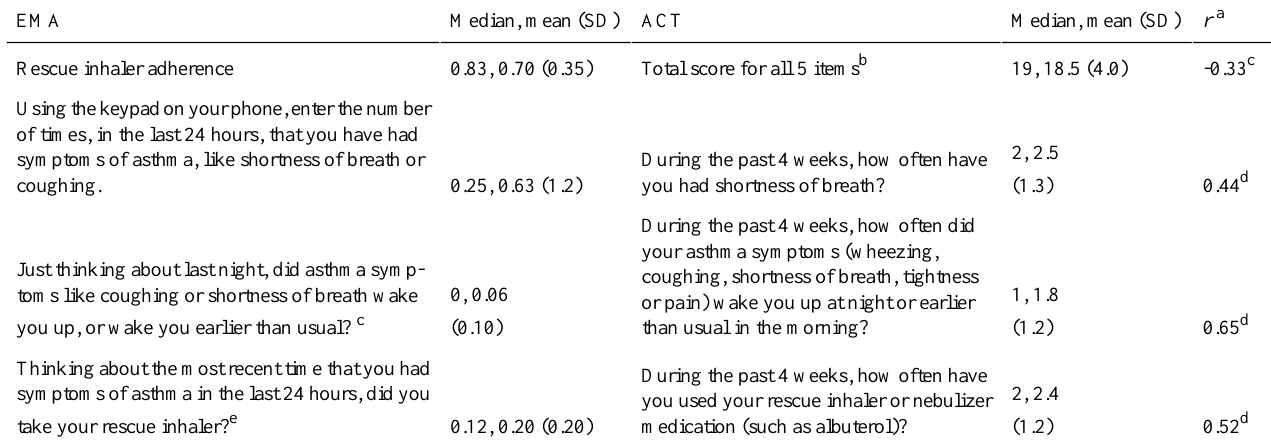
Table 2. Comparisons of EMA-measured rescue inhaler adherence and ACT scores for totals and corresponding